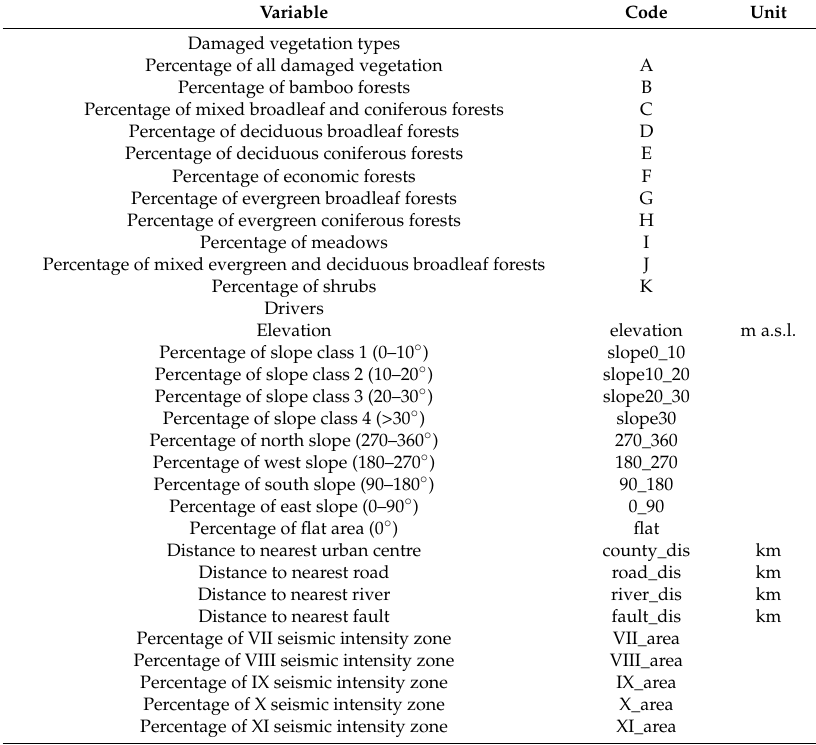
Table 4. The damaged vegetation types and potential drivers used in the statistical analysis in nine severely damaged cities and